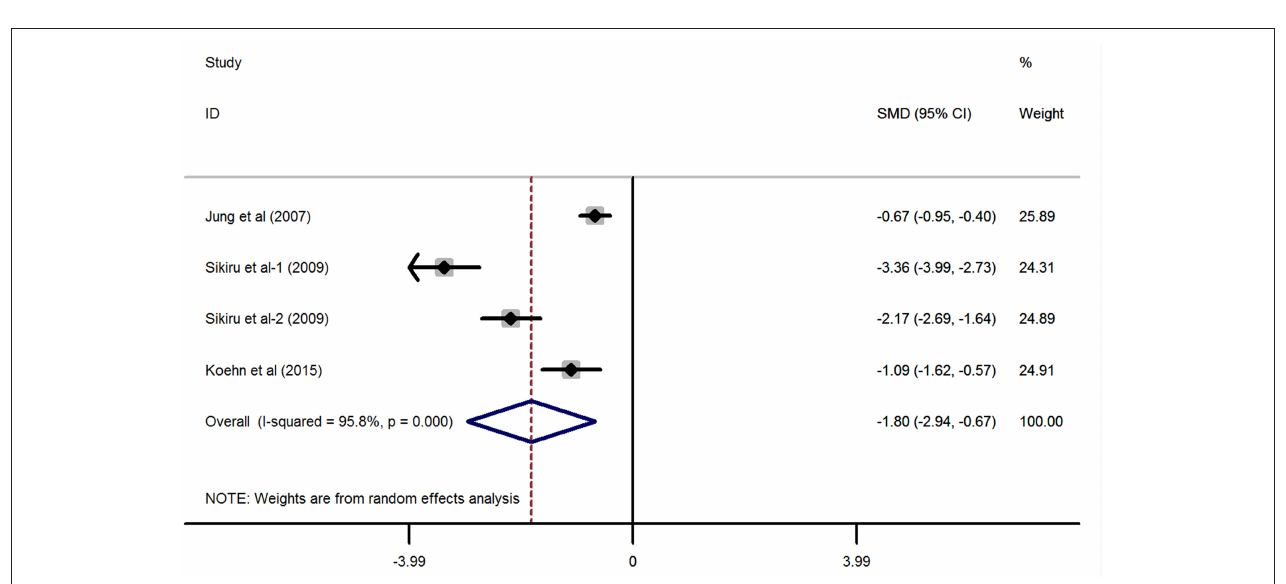
FIGURE 3 | Forest plots of the meta-analysis based on the three included studies reporting the IIEF-5 scores.